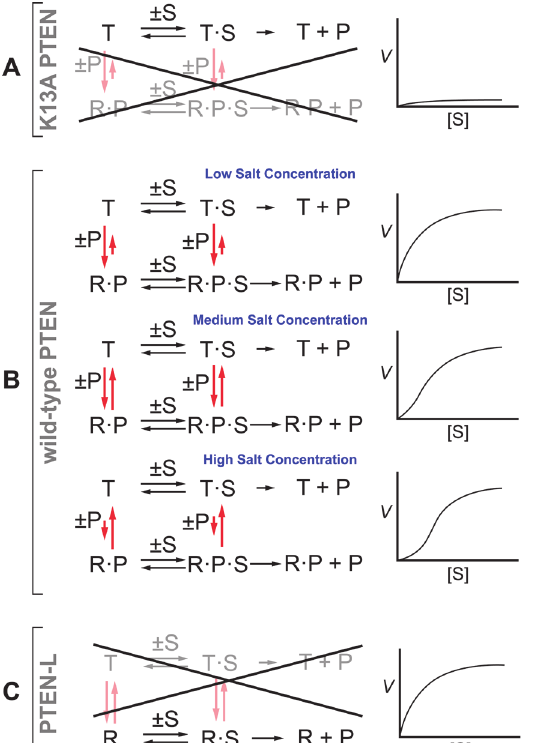
Figure 7. Notional schemes and diagrams for catalysis by K13A PTEN, wild-type PTEN, and PTEN-L. (A) The binding motif for PIP 2 (P) is absent in K13A PTEN. As a result, the K13A variant remains in its tense (T) state for all substrate concentrations at any salt concentration. (B) Wild-type PTEN has complex kinetic behavior. Low salt concentration favors the binding of PIP 2 . The wild-type enzyme is in its relaxed (R) state and exhibits Michaelis – Menten kinetics. Increasing salt concentration leads to decreasing affinity for PIP 2 and a greater fraction of the enzyme being in the T state. As more PIP 3 (S) is hydrolyzed, the increasing concentration of P leads to a greater fraction of the enzyme being in the R state. (C) PTEN-L is in the R state at any salt concentration and is unaffected by